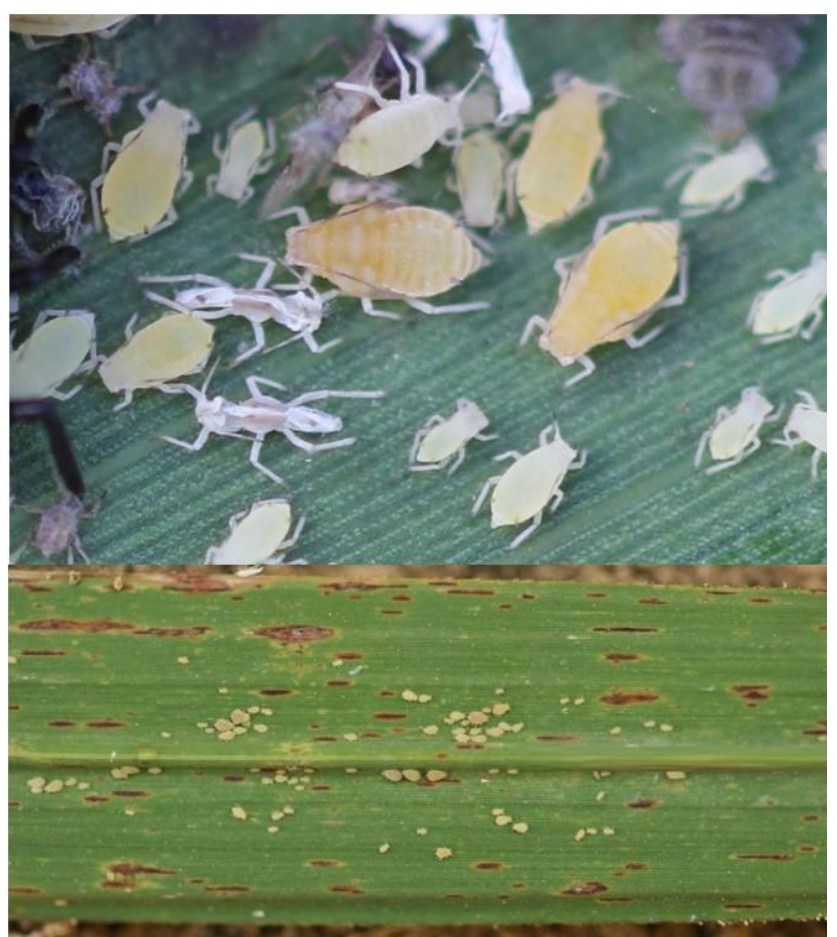
Figure 1. Melanaphis sacchari adults, nymphs, and exuvia (top); and colony on the underside of a sugarcane leaf (bottom). Photos © B.E. Wilson.